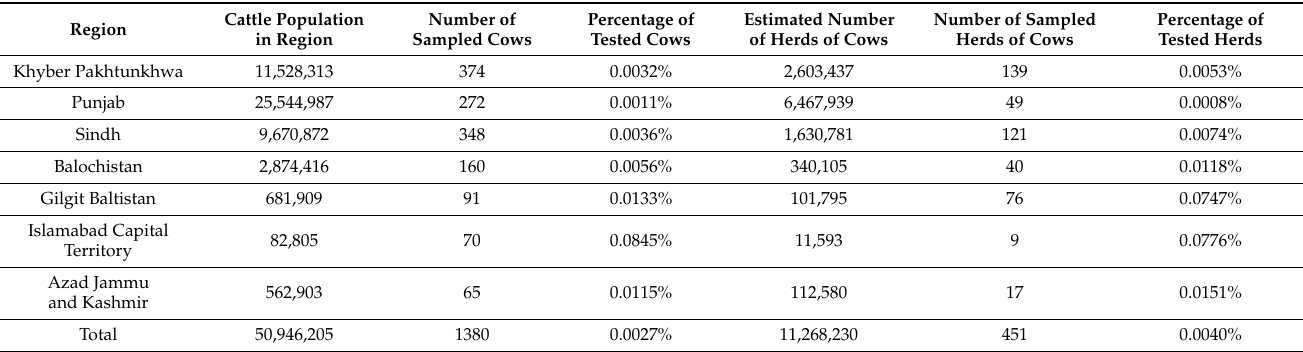
Table 1. Overview of the sampling scheme used in this study Region Cattle Population in